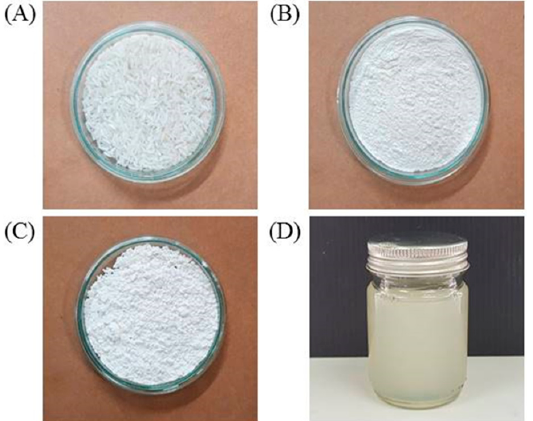
Figure 1. Outer appearance of ( A ) rice grains; ( B ) raw rice powders; ( C ) modified rice powders and ( D ) rice gel preparation.